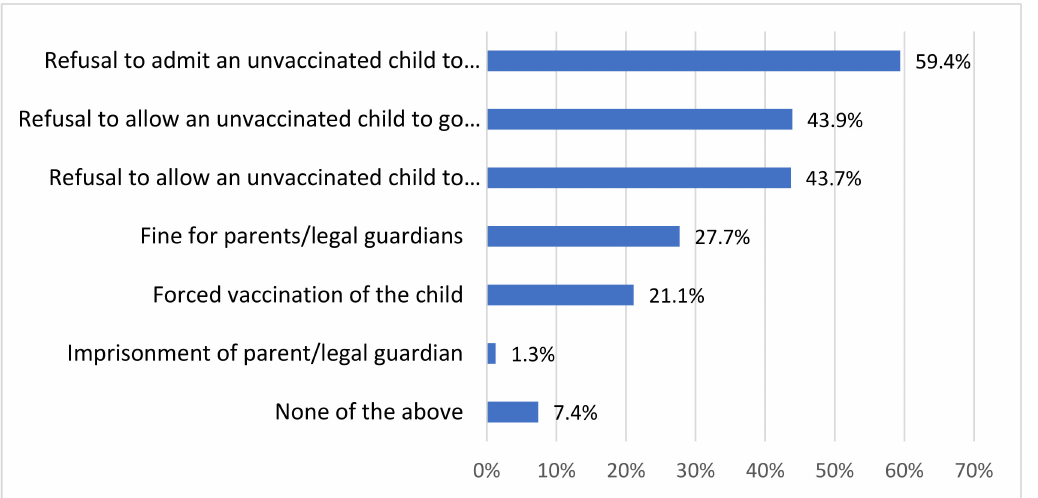
Figure 2. The percentages of respondents admitting specific sanctions against individuals refusing mandatory vaccination of their children. This question was asked only of those respondents who had stated that they would accept sanctions against vaccine refusers ( n =